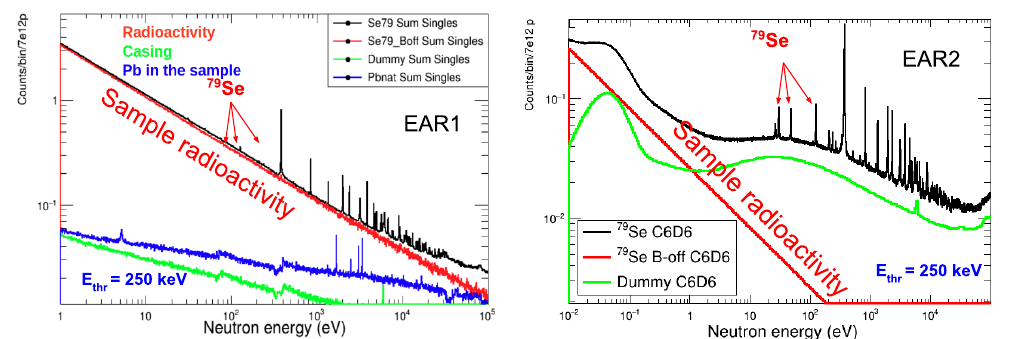
Figure 1. Total counts and background components as a function of the neutron energy measured with the PbSe ( 78 + 79 Se) sample in EAR1 (left) and EAR2 (right). The first resonances of 79 Se are highlighted.